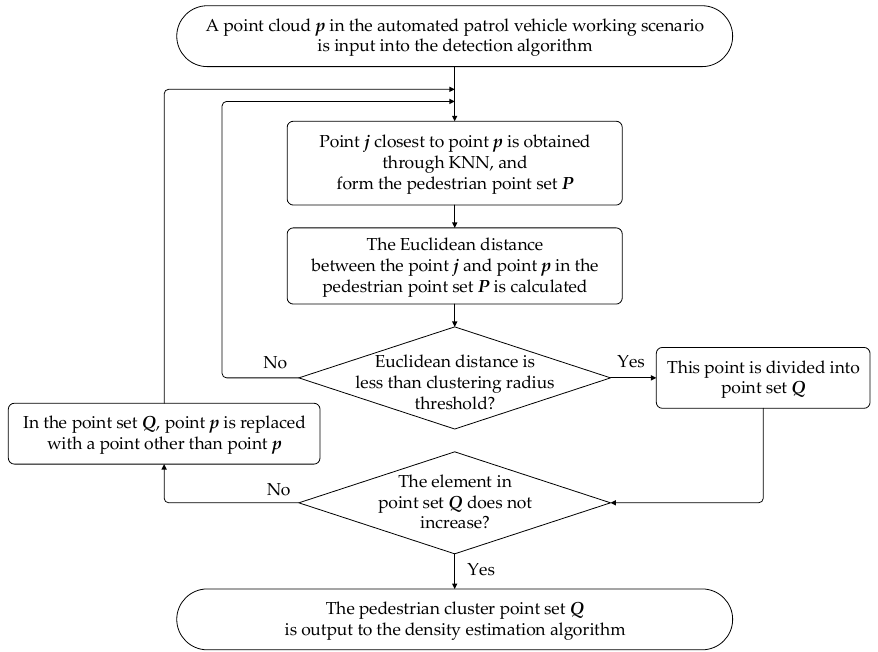
Figure 4. Flow chart of pedestrian point cloud detection based on Euclidean clustering algorithm.